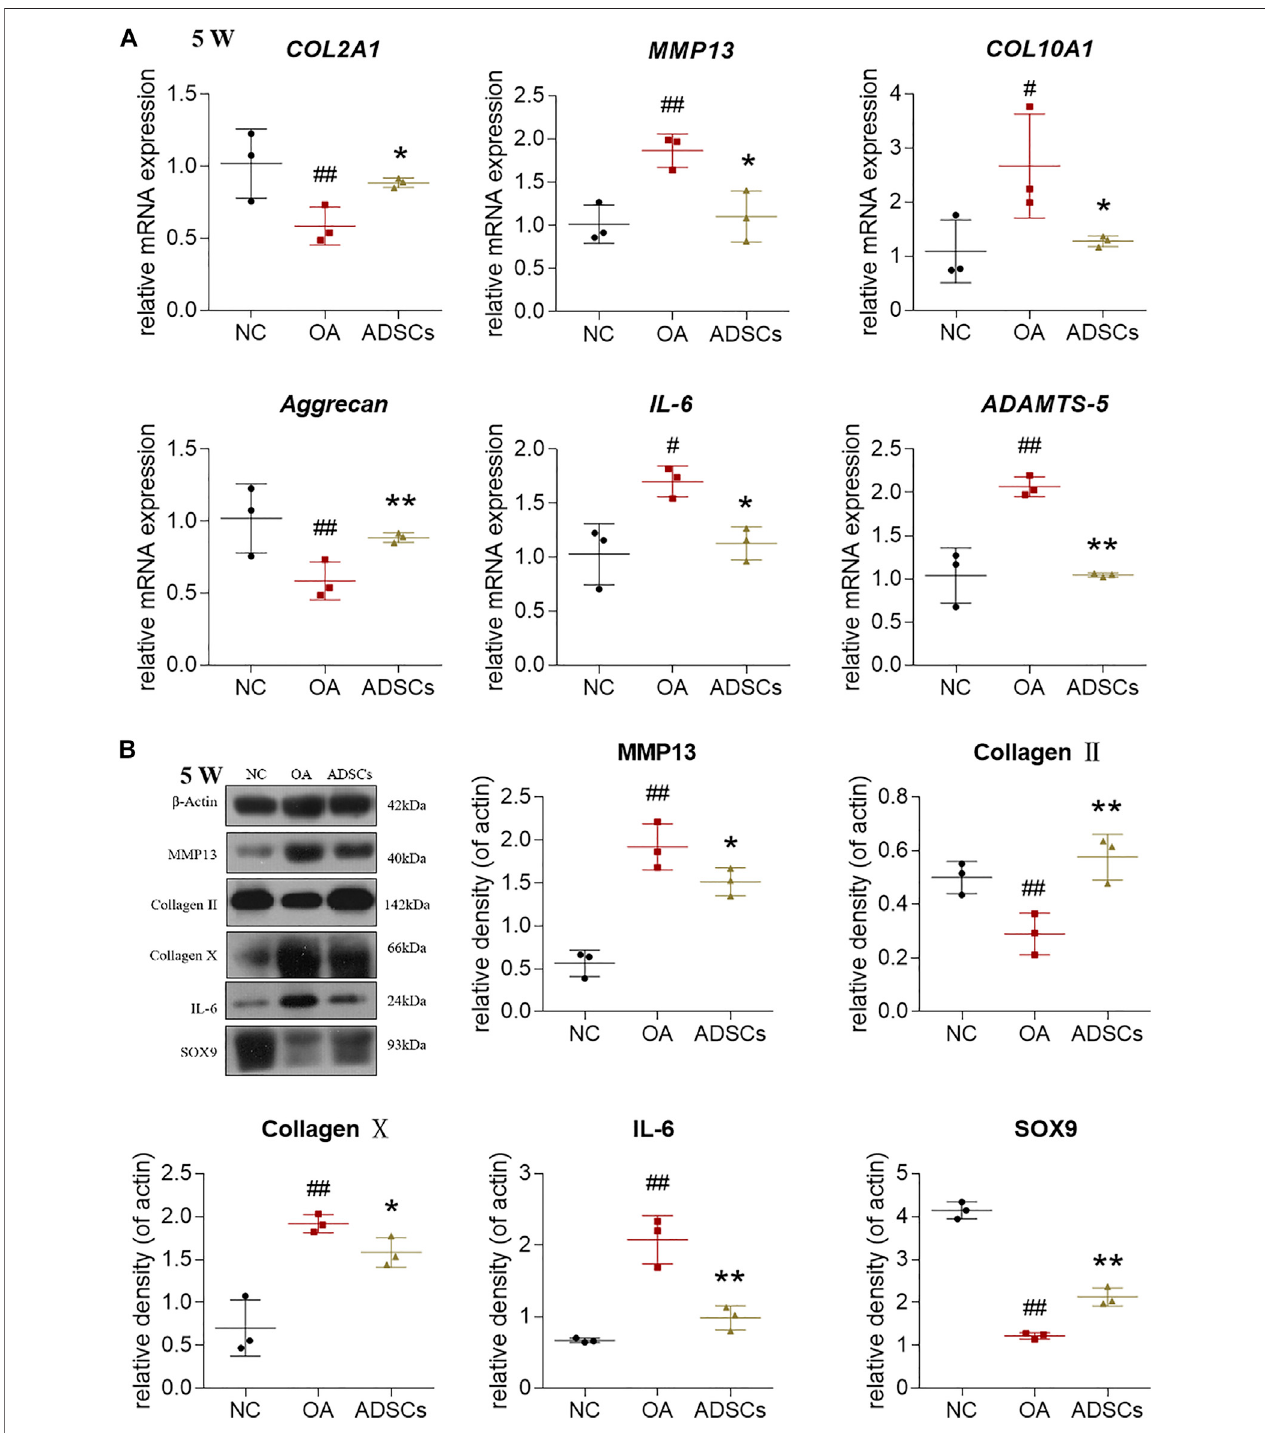
FIGURE 4 | Effects of ADSCs on chondrocytes in rat cartilage. (A) qRT-PCR analysis of mRNA expressions of chondrocytes treated with ADSCs on rat cartilage; (B) Expressions of target proteins in chondrocytes treated with ADSCs on rat cartilage. Data were collected at the fi fth week of the experiment (5 W). Values were presented as mean ± SD. N = 3. # p < 0.05 and ## p < 0.01 versus NC group; * p < 0.05 and ** p < 0.01 versus model group.